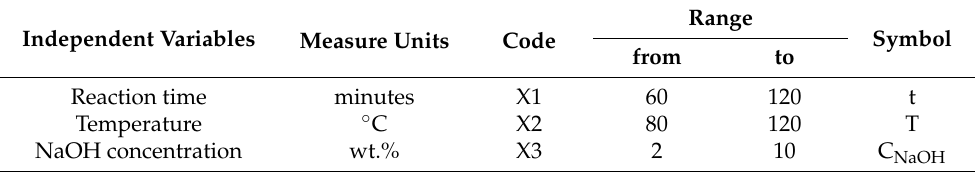
Range Symbol from to